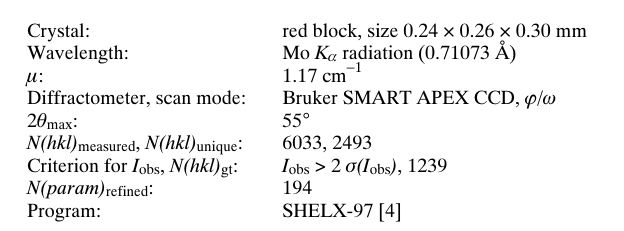
Table 1. Data collection and handling.